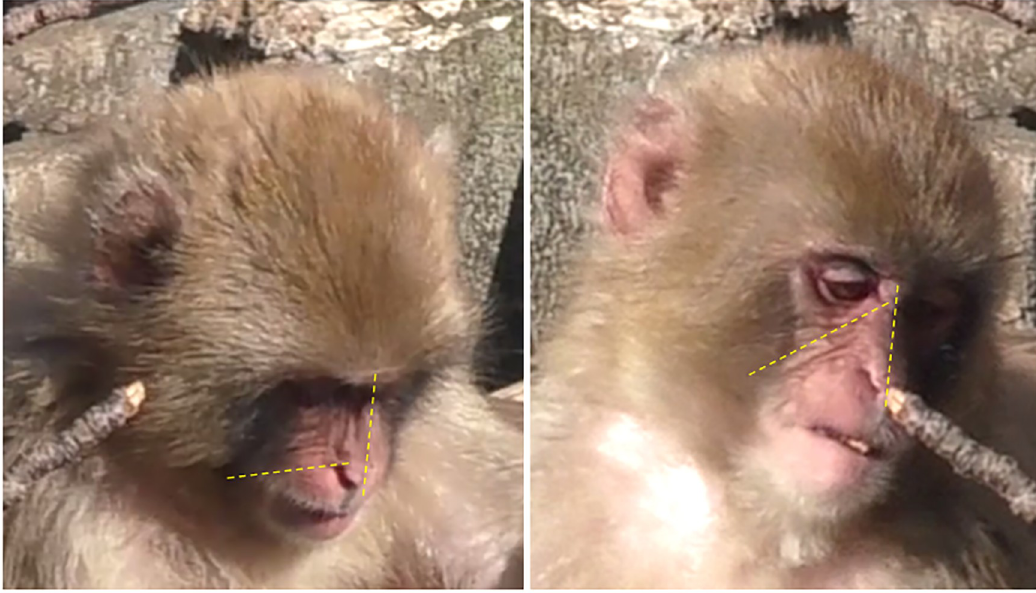
Fig 9. Left: AU10 with perpendicular wrinkles to the nose . Right: AU9+10 with wrinkles oblique to the nose (angle of wrinkles indicated by yellow dashed lines).